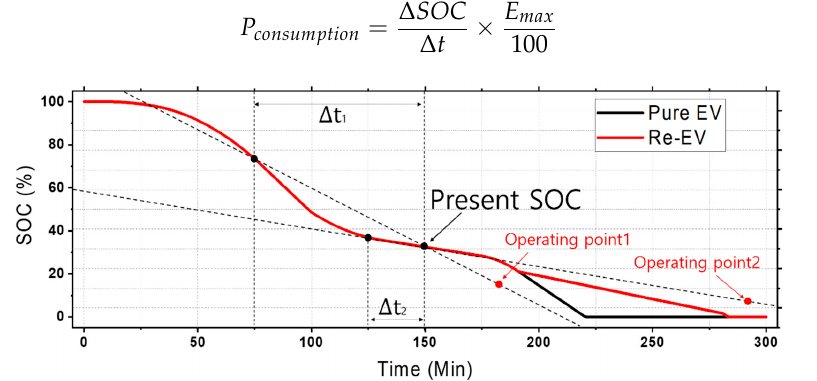
Figure 3. Operating point determination in the case of non-linear power consumption.